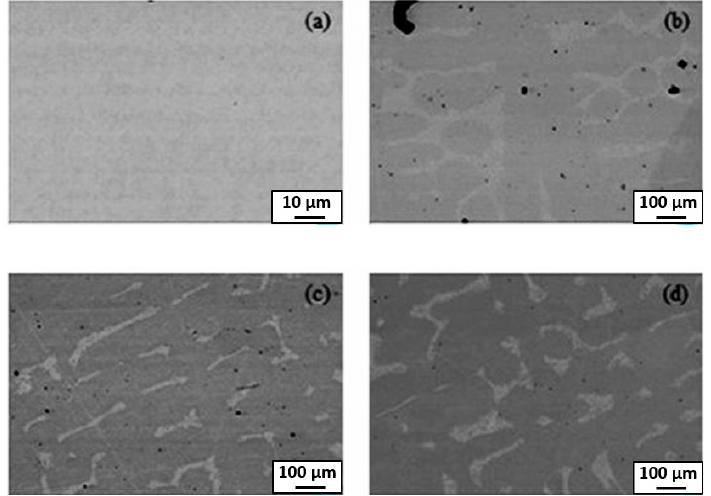
Figure 5. BSE-SEM pictures of ( a ) homogenized and quenched sample (CoCrFeMnNi) 100-5 Ti 5 as well as the samples following aged at 750 °C ( b ) 2 h, ( c ) 10 h and ( d ) 20 h. The images are not from the same spot and were obtained from different samples. Reprinted with permission from Ref. [37]. Copyright 2021 Elsevier.